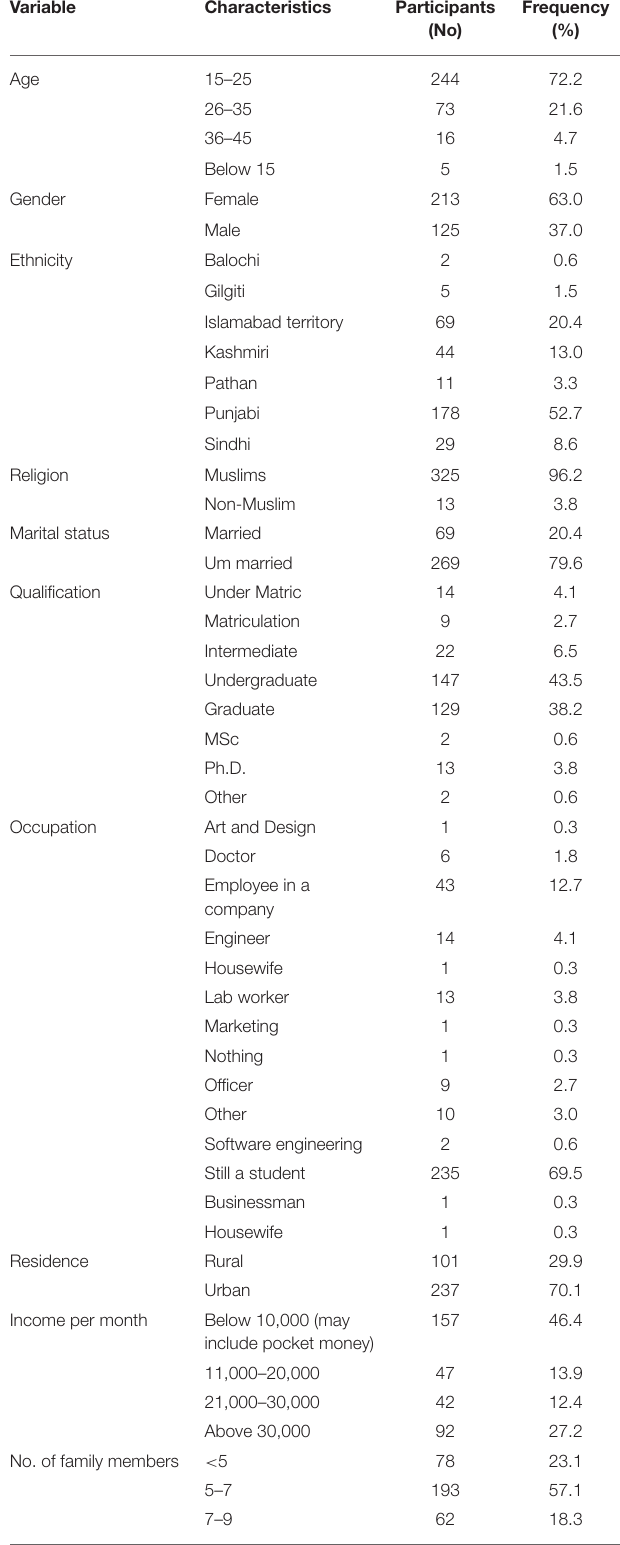
TABLE 1 | Socio demographic background of the